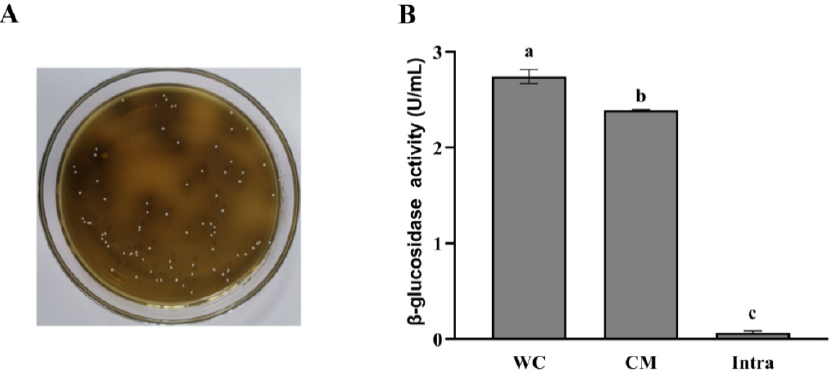
Figure 2. ( A ) Production of β -glucosidase from Lactobacillus rhamnosus L08 detected in Esculin-MRS agar medium; ( B ) subcellular location of β -glucosidase in Lactobacillus rhamnosus L08. WC: whole-cell concentrates, CM: cell-membrane extracts, intra: intracellular extracts. Data are means ± SD of three biological replicates. Bars labeled with different letters are significantly different ( p < 0.05).